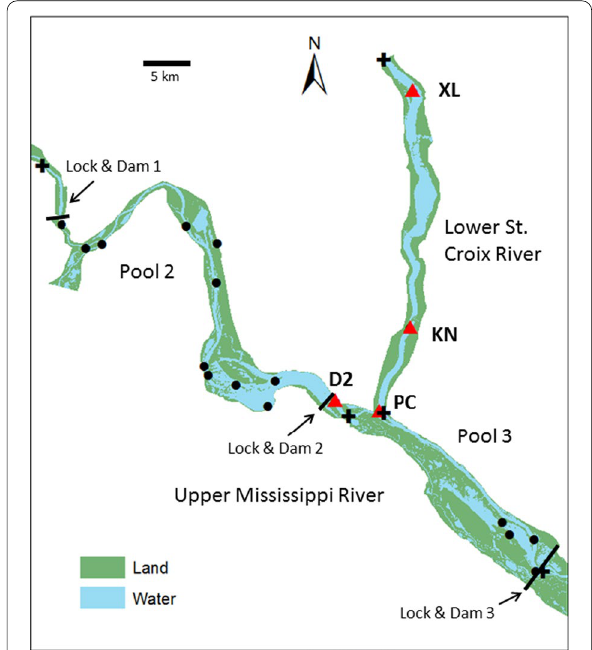
Fig. 1 Sampling locations (dot) for lake sturgeon and water quality (cross) in the St. Croix and Mississippi Rivers. Triangles denote locations where sturgeon where captured (XL near Xcel Energy = Plant, Stillwater, Minnesota, USA; KN near Kinnickinnic narrows; = PC near Prescott, WI, USA; D2 tailwaters below Lock and Dam 2). = = The location of navigation dams on the Mississippi River are indicated by bars. Sampling locations for water quality in the Chippewa River (near Durand, Wisconsin) and Minnesota River (near Jordan, Minnesota) are not